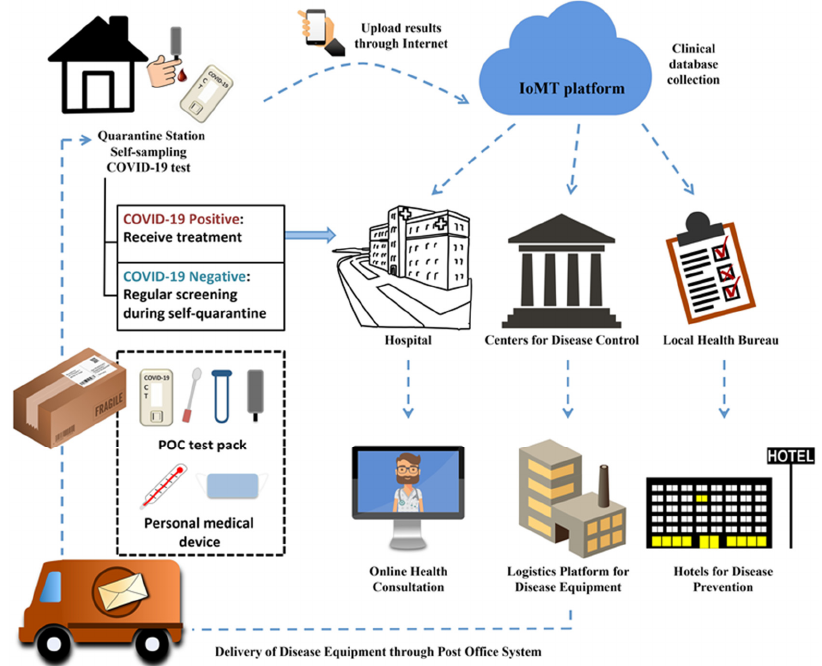
Figure 1. Schematic of the medical ecosystem concept for combating coronavirus disease 2019 (COVID-19): combined implementation of point-of-care (POC) diagnostics and the Internet of Medical Things